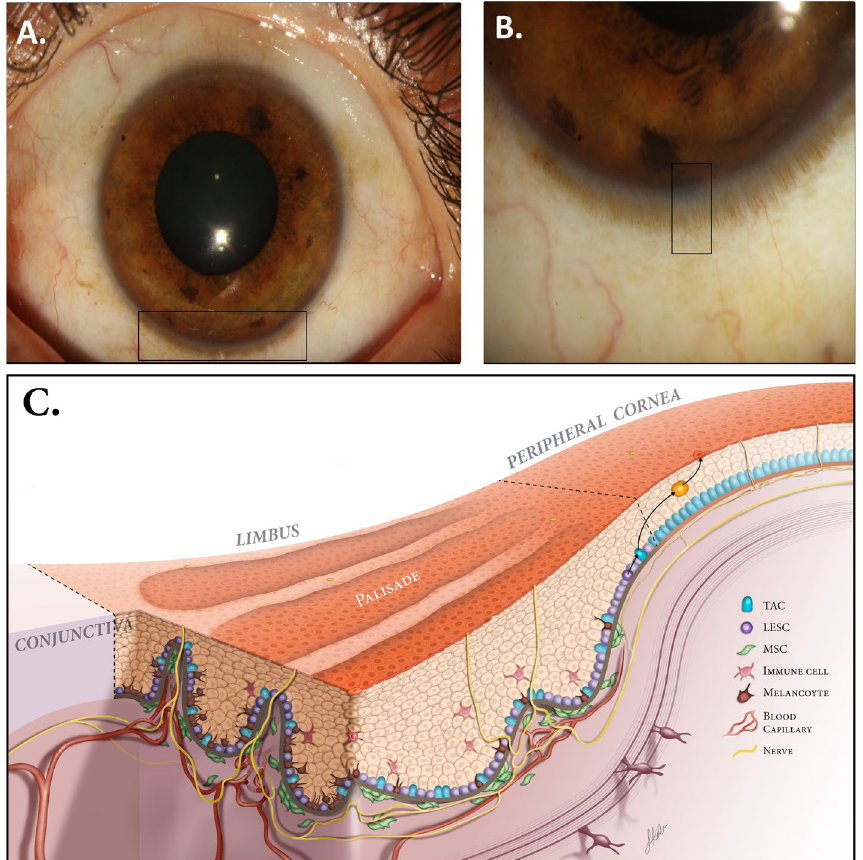
Figure 1. Normal ocular surface and limbus. ( A ) The corneoscleral limbus contains the palisades of Vogt (PVs), which have a length of 0.31 mm and a width of 0.04 mm and are typically more detectable on the superior and inferior sections of cornea. ( B ) Corneoscleral junction with magnification showing PVs. ( C ) The PVs contain different cells, such as melanocytes, mesenchymal stem cells, and immune cells. These cells, along with neurovasculature, provide growth factors, nutrients, and structural support to promote proper LESC proliferation and differentiation (LESC: limbal epithelial stem cell, TAC: transient amplifying cell, MSC: mesenchymal stem cell). Modified with permission from [14] .